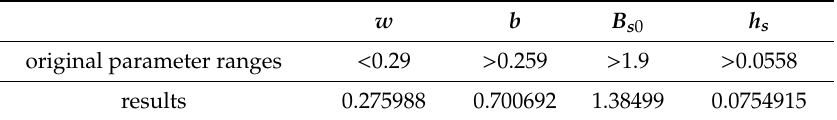
Table 4. The comparation between the results and the original parameter ranges of the ‘maria’ area. w b B s 0 h s <